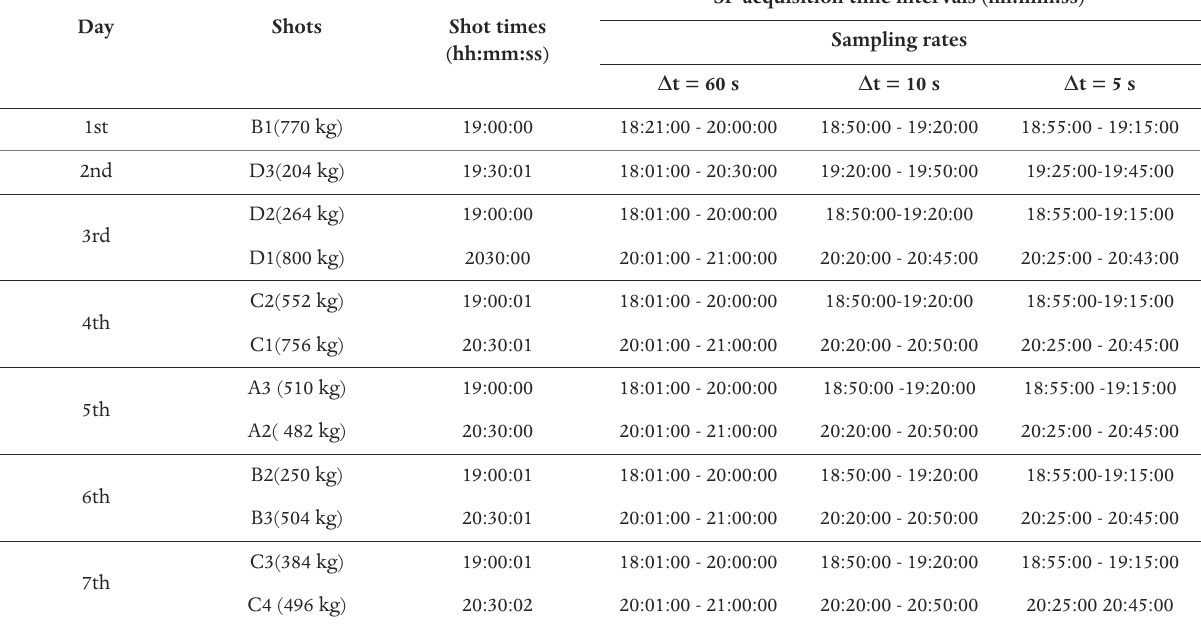
Table 1. Sampling time intervals used for the SP data acquisition along the dipoles AB and AC of Figure 1. Date, time and dynamite charge of the shots are also